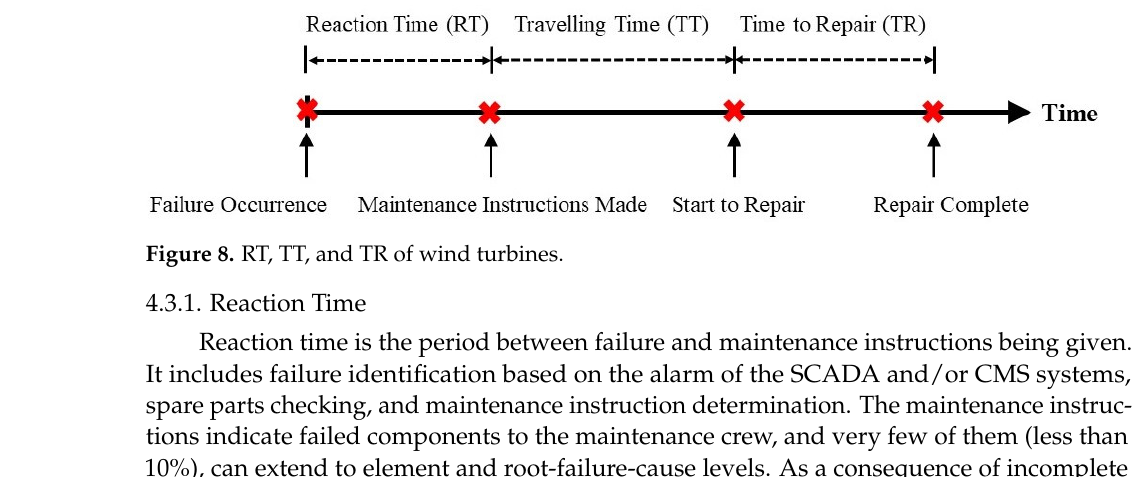
Figure 9. RTs of the maintenance of the 375 failures. The average RT of the 375 failures is 41 h. However, 147 failures (nearly 40% of the total) with an RT of zero indicate that the maintenance instructions of some frequently occurring or difficult-to-repair failures can be made without any delay. Moreover, the av- erage RT of the remaining 228 failures is 68 h. To be specific, the maintenance instructions of 200 failures (88% of the total) are made within a day, 212 failures (93%) within a week, and 220 failures (96%) within a month. Eight generator, blade, and converter failures contribute an 86% RT to the total (see Figure 10). Logistics, spare parts, and complexity in maintenance are primary factors of RTs. Specifically, the bearing degradation (calling for replacement) of generators, the pro- tective film peeling off the blades, and control circuit-board damage of the converter result in long RTs as there is no possibility of backing up such components in storerooms, for wind farms or for manufacturers. Moreover, the logistics with unpredictable risks, high costs, and complex maintenance require a longer waiting time for professional personnel, which further delays the RTs.